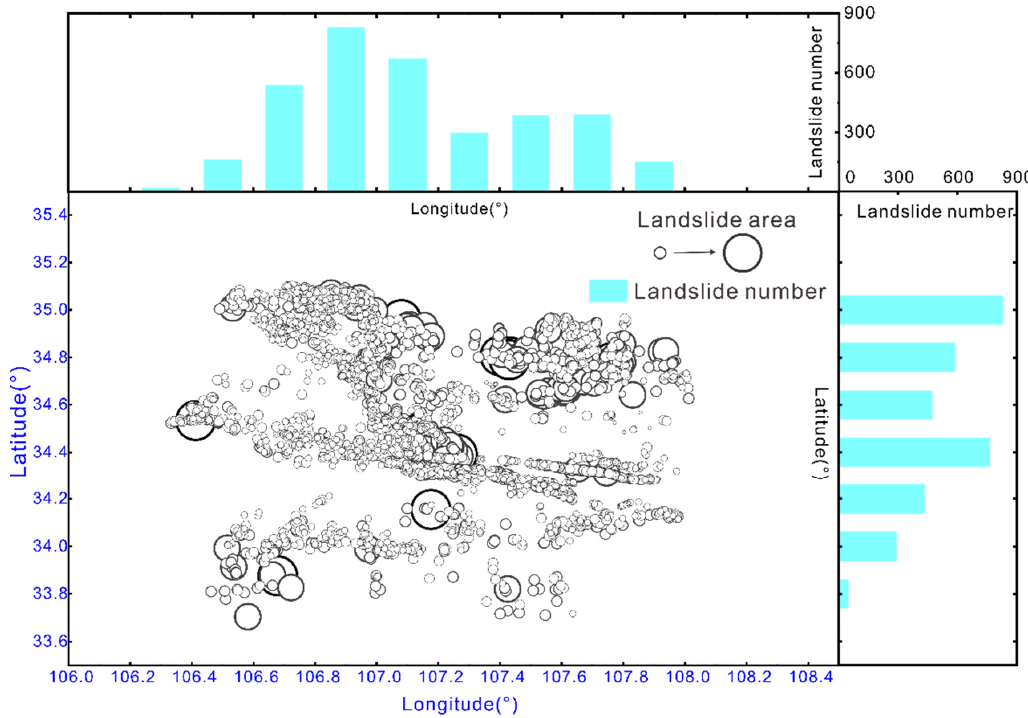
Figure 5. Spatial distributions of landslides identified. Table 3. Locations of landslides documented in the literature. Table 3. Locations of landslides documented in the